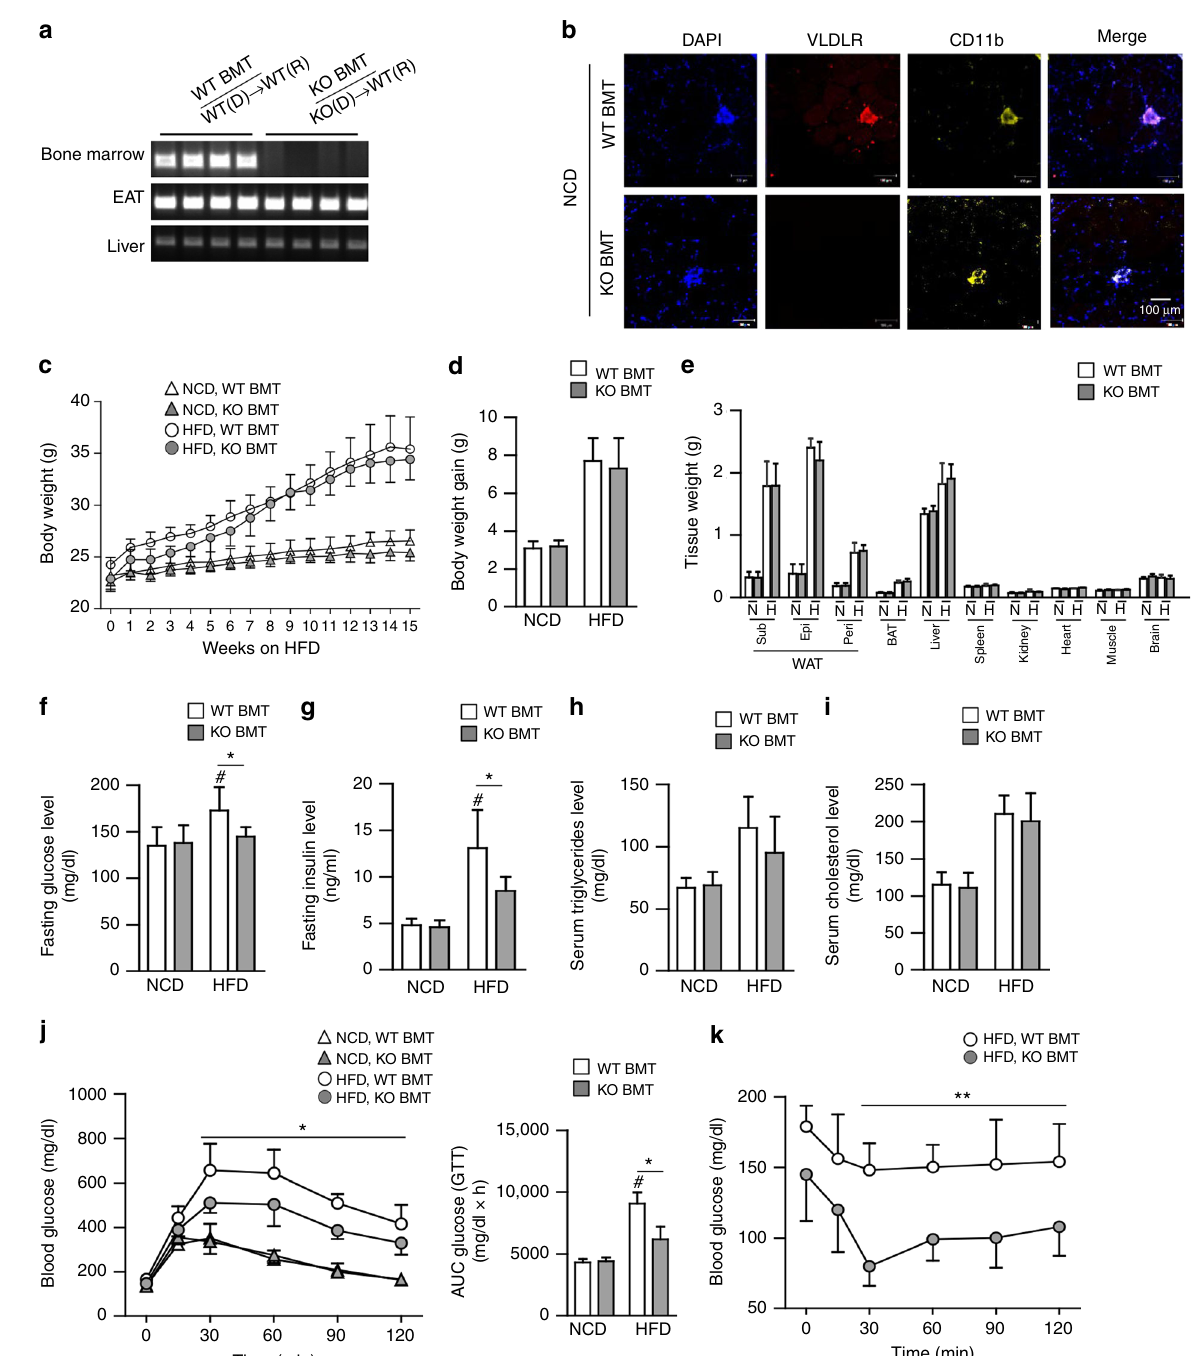
Fig. 7 HFD-fed KO BMT mice ameliorate insulin resistance. a – k WT BMT [WT(D) → WT(R)] and KO BMT [KO(D) → WT(R)] mice ( n = 6/group) were fed NCD or HFD for 15 weeks. a WT and KO BMT mice were genotyped. Genomic DNAs were isolated from bone marrow, EATs, and livers from WT and KO BMT mice. b Expression patterns of VLDLR protein in ATMs of WT and KO BMT mice. Whole-mount immunohistochemistry of the nucleus (blue), VLDLR (red), and CD11b (yellow) in NCD-fed EAT. c Body weights throughout the experimental period. d Total body weight gain and e various tissue weights in WT and KO BMT mice after NCD (N)-fed or HFD (H)-fed 15 weeks. f – i Fasting serum glucose ( f ), insulin ( g ), triglyceride ( h ), and cholesterol ( i ) in WT and KO BMT. j Glucose tolerance test (GTT), area under the curve (AUC), and k insulin tolerance test (ITT) analysis of WT and KO BMT mice. Data represent mean ± SD. # P < 0.05 vs. HFD, * P < 0.05; ** P < 0.01, Student ’ s t